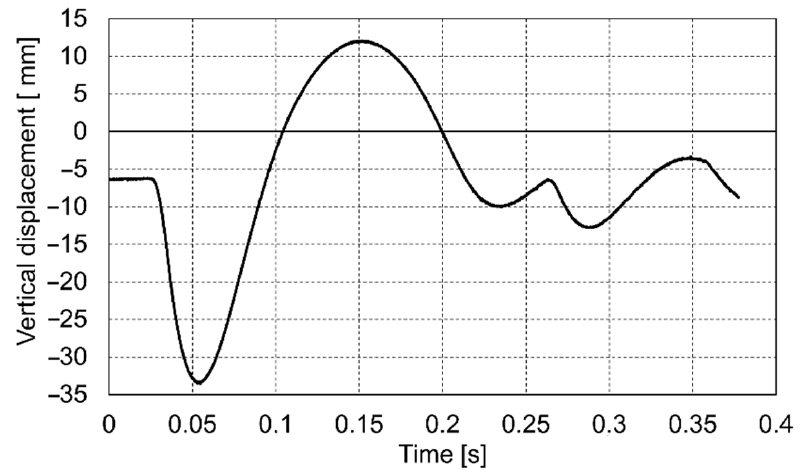
Figure 11. Vertical displacement of the p0 point during drop No. 3.